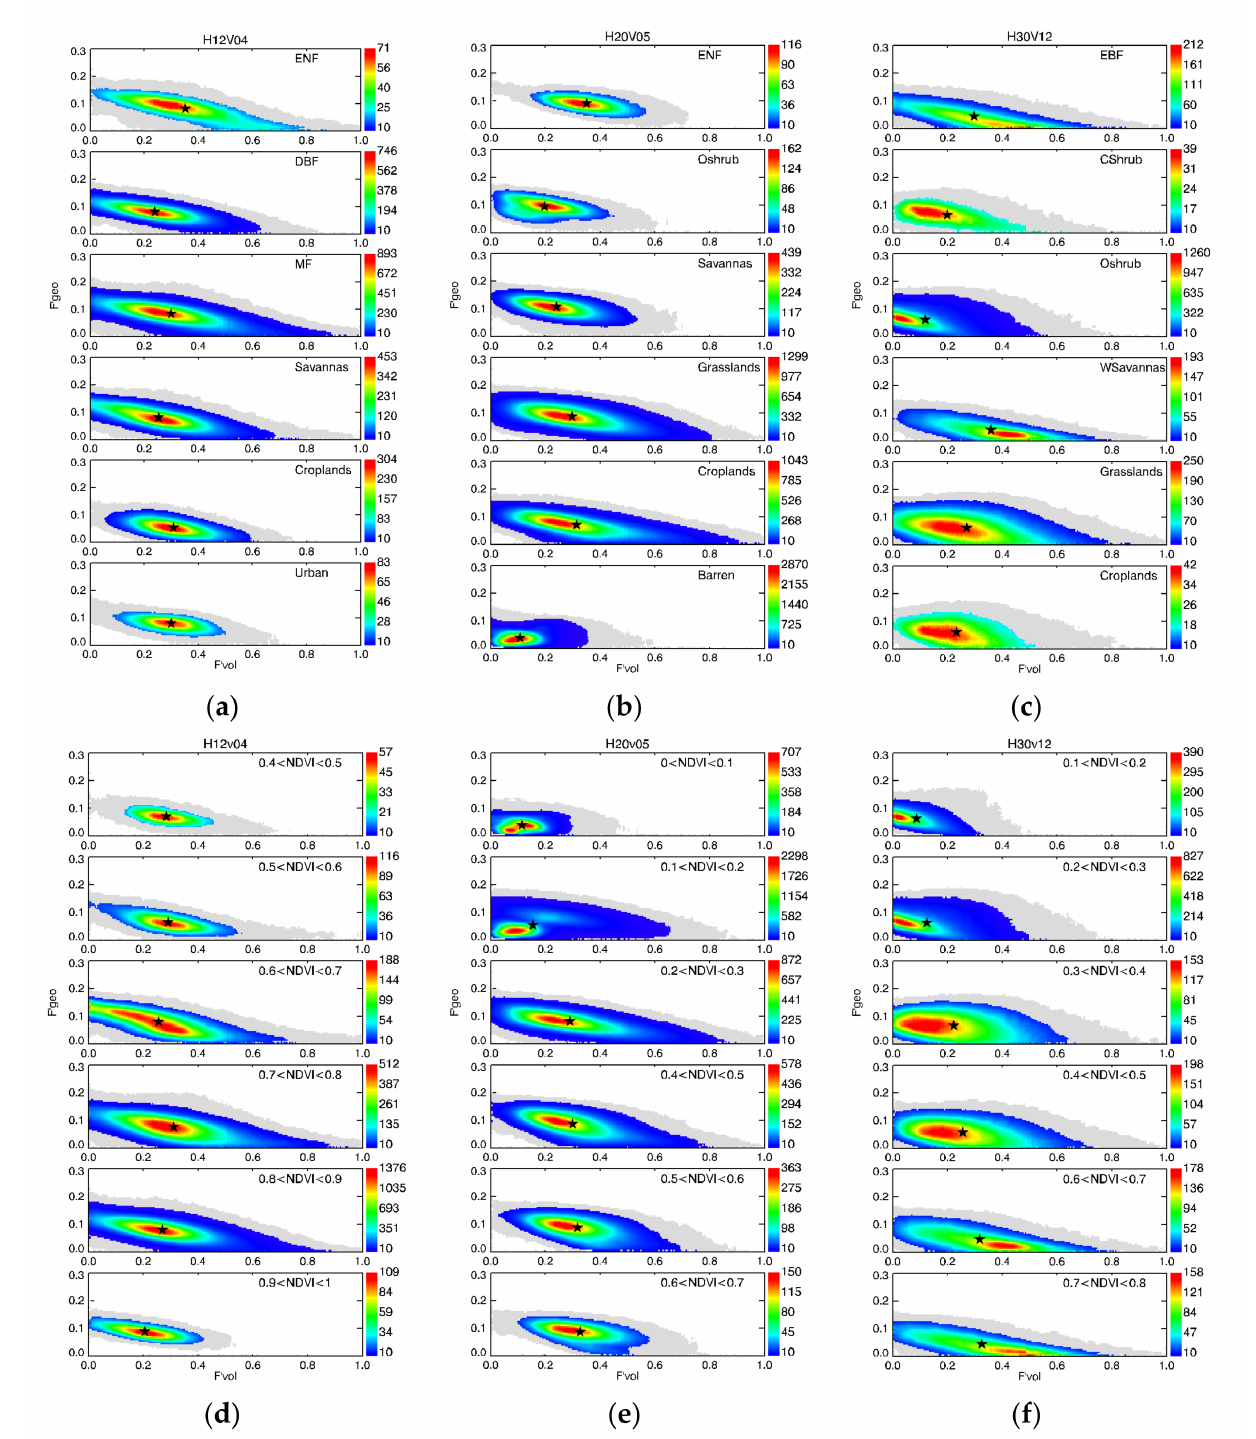
Figure 5. The scatter diagrams of F (cid:48) vol and F (cid:48) geo in shortwave broadband for six main LCTs ( a – c ) and different ranges of NDVI ( d – f ) in h12v04, h20v05, and h30v12. The LCTs include Evergreen Needleleaf Forests (ENF), Evergreen Broadleaf Forests (EBF), Deciduous Broadleaf Forests (DBF), Mixed Forests (MF), Closed Shrublands (CSH), Open Shrublands (OSH), Woody Savannas (WSV), Savannas (SV), Grasslands (GRA), Croplands (CRO), Urban and Built-up Land (UBL), Cropland/Natural Vegetation Mosaics (CNM), and Barren (BRN). The pentacle represents the location of F